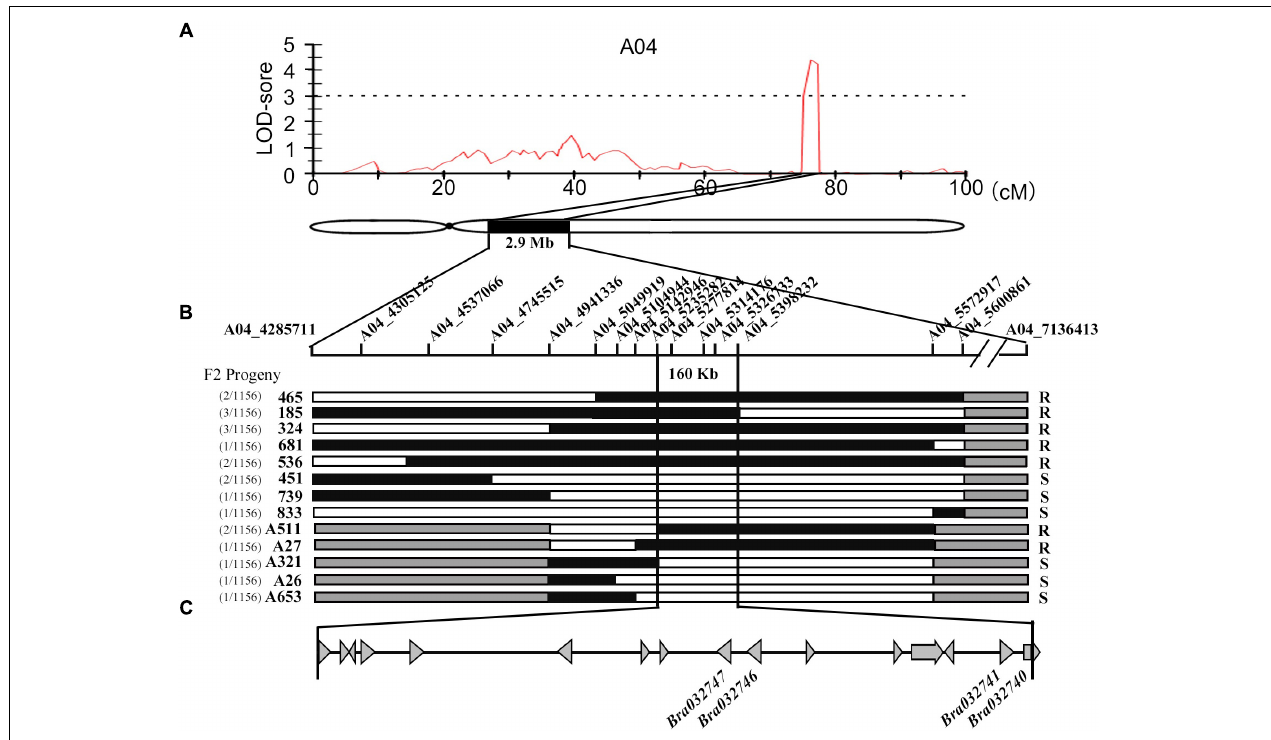
FIGURE 1 | Fine mapping of the downy mildew resistant QTL Bra-DM04. (A) Major QTL likelihood maps by multiple QTL model (MQM). The LOD-score threshold of 3.1 is indicated by the dashed line. The highest LOD score of 4.2 was located in a 2.75 cM on A04 Chromosome between SNP marker A04_4285711 and A04_7136413. Below the likelihood map was the schematic diagram of Chromosome A04, on which a 2.9-Mb region corresponding to the 2.75 cM region in likelihood map was filled with black. (B) F 2 population was applied to fine mapping of Bra - DM04 , narrowing down the area to 160 kb. The SNP markers used for mapping are labeled on a schematic diagram of the chromosome. The representative genotypes of recombinants were below the chromosome. The numbers of recombinants of the same genotype and the total number of population are written on the left of the recombinants’ names. Phenotypes are on the right. “R” and “S” refer to resistant and susceptible, respectively. Black and white rectangles represent resistant and susceptible genotypes, respectively. Gray segments indicate regions that were not tested with markers. (C) The gray triangles denote the genes in Bra - DM04 . This region contains 16 candidate genes, among which four predicted resistance genes are